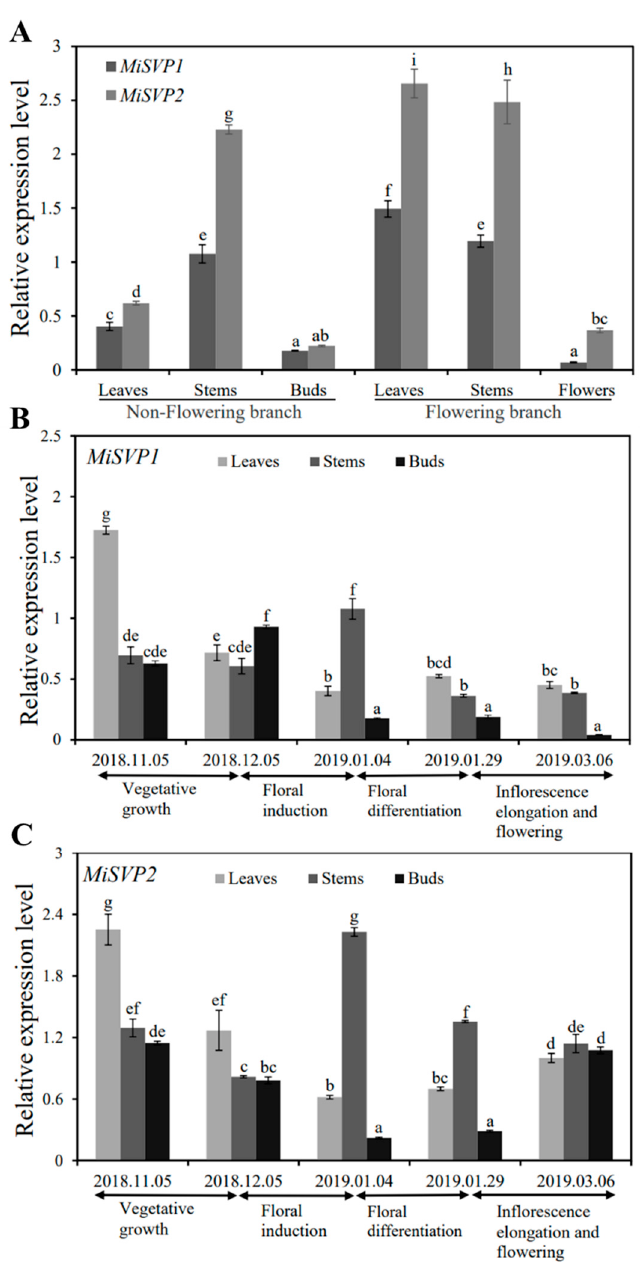
Figure 2. Tissue and temporal expression analyses of MiSVP1 and MiSVP2 in mango. ( A ) Tissue expression analysis of MiSVP1 and MiSVP2 in the different tissues of mango. ( B , C ) Temporal expression analysis of MiSVP1 and MiSVP2 at different floral development stages. The vegetative growth phase was 5 November 2018, to 5 December 2018. Floral induction was 5 December 2018 to 4 January 2019. The floral differentiation phase was 4 January 2019 to 29 January 2019. The inflorescence elongation and flowering phase was 29 January 2019 to 6 March 2019. The MiActin1 gene served as an internal control. Duncan’s multiple range test was used to analyze the significance of differences among multiple groups of samples, and p < 0.05 indicated a significant difference. The error bars represents the standard error of the mean (± SE) among three replicates of the same sample.